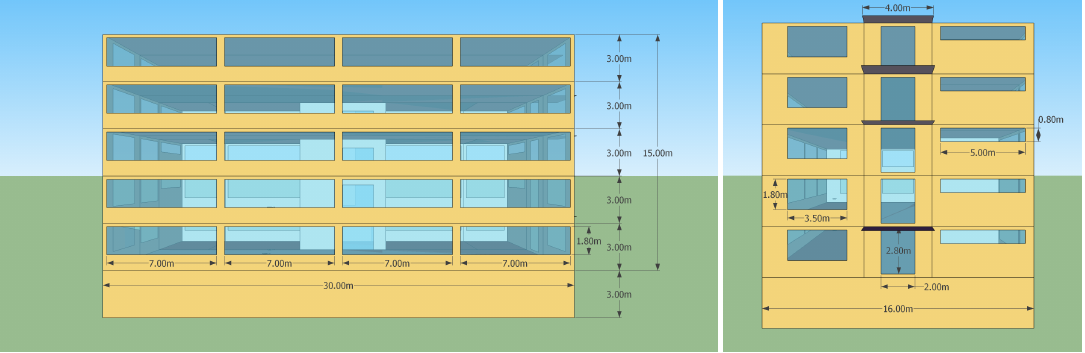
Figure 3. Layout of simplified office building design used for the EnergyPlus